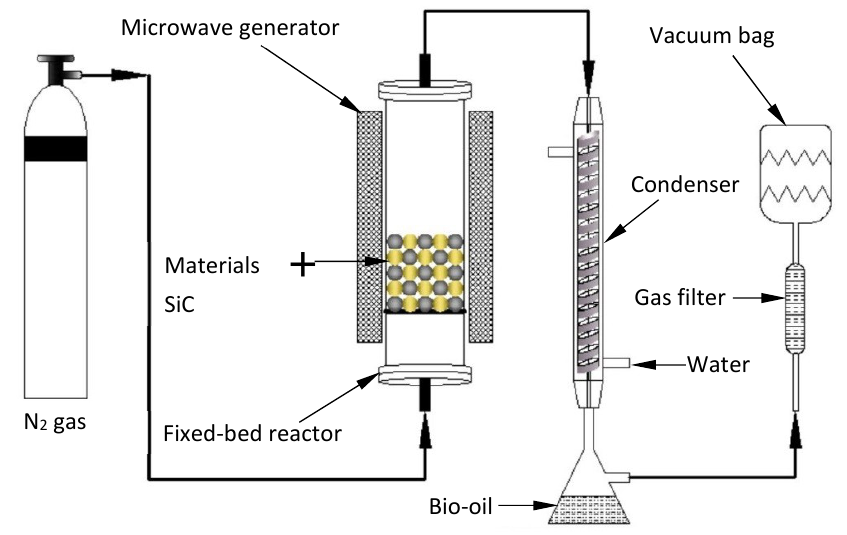
Figure 1. Schematic diagram of pyrolysis reactor.